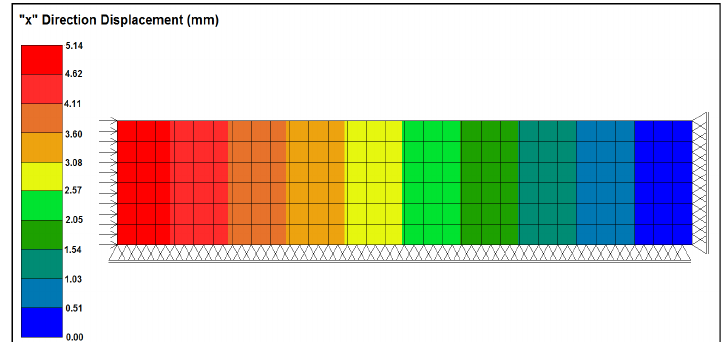
Figure 10. Field of creep longitudinal displacements: Day 860 - Case 1.